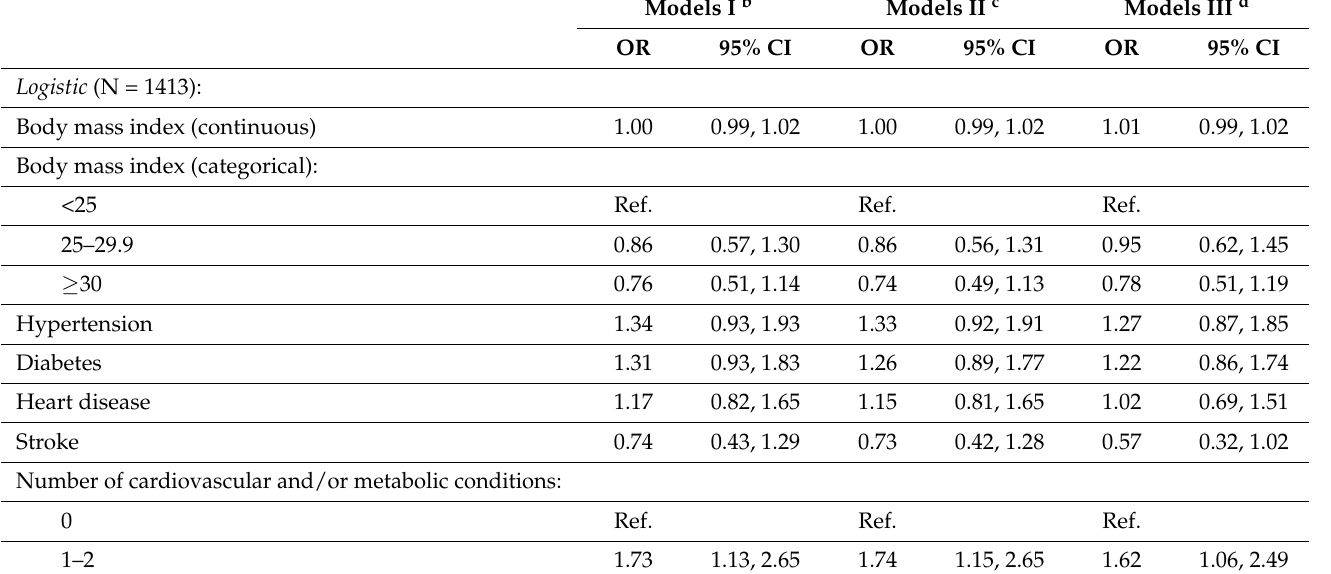
Table 2. Logistic regression models for cardiovascular and/or metabolic conditions as predictors of healthcare delays–HRS COVID-19 half-sample a . Models I